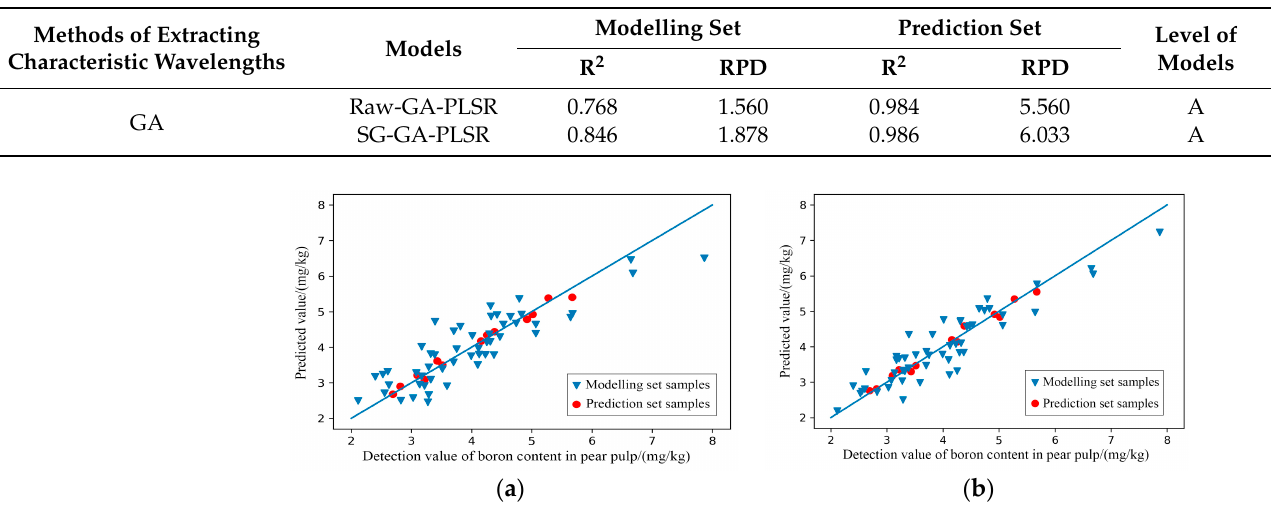
Table 4. Modelling prediction results of the content of boron in pear pulp based on the selected characteristic wavelengths.